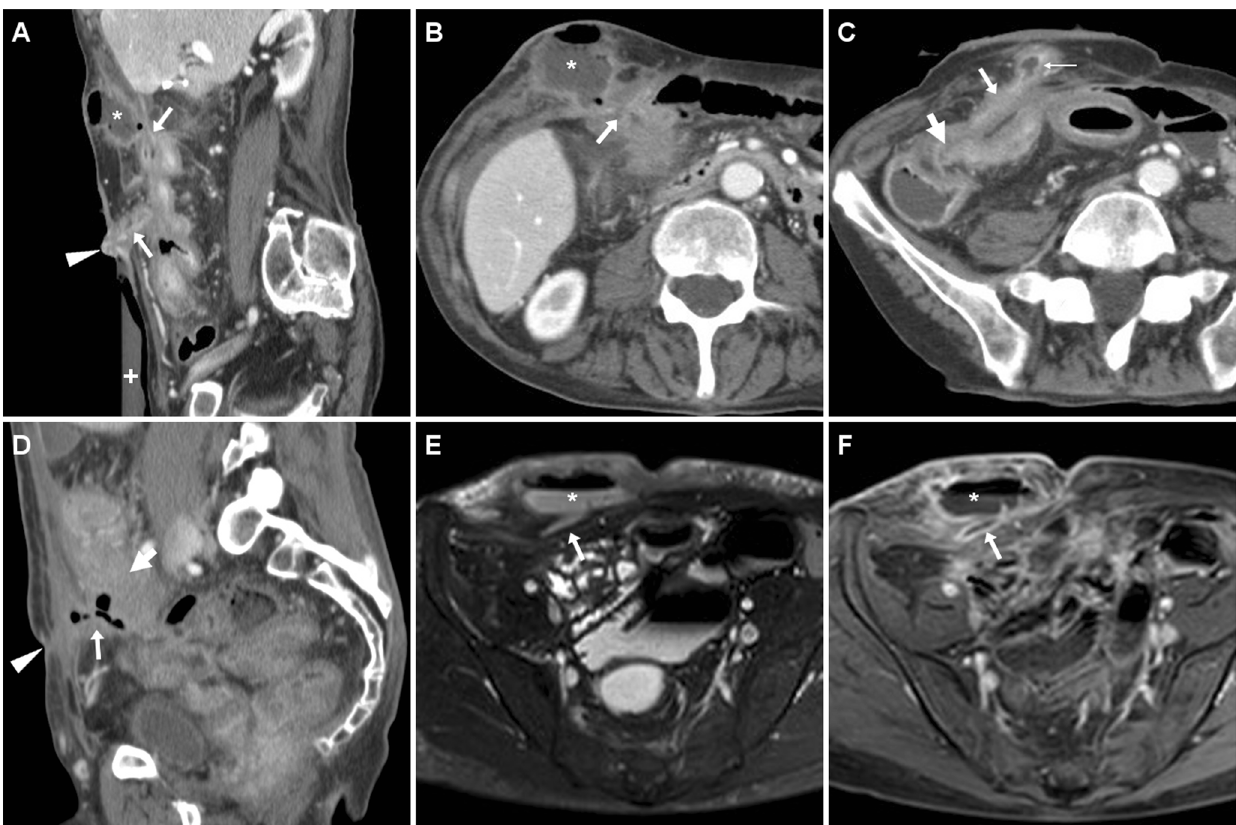
woman with fistulising CD, the ECF corresponded at CT ( D ) to a gas- filled track (arrow) arising from the diseased ileocolonic anastomosis (thick arrow) and reaching a subtle depressed EFO (arrowhead). Follow-up MRI including T2- ( E ) and post-contrast fat-saturated T1- weighted ( F ) showed development of a large abscess (*) with fluid con- tent and enhancing wall along the ECF (arrows); definitive surgical treat- ment required extensive adhesiolysis, resection of rectum and of diseased perianastomotic